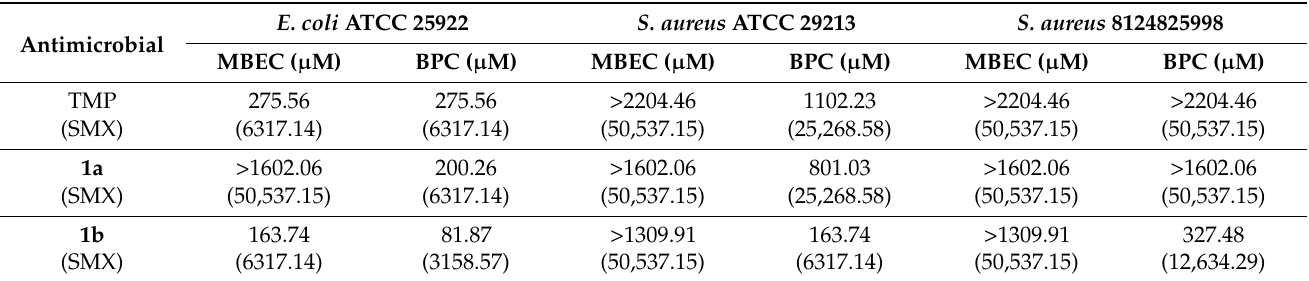
Table 2. The minimum biofilm eradication concentration (MBEC, µ M) and biofilm prevention concentration (BPC, µ M) of TMP and the GBBR analogues 1a and 1b when tested alone and in combination with SMX (1:20) against E. coli ATCC 25922, S. aureus ATCC 29213, and S. aureus 8124825998. Antimicrobial